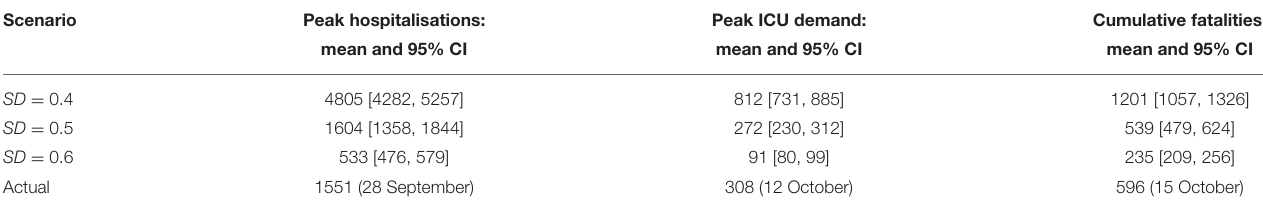
TABLE 3 | Estimates (across Australia) of the peak demand in hospitalisations and ICUs; and cumulative fatalities (15 October